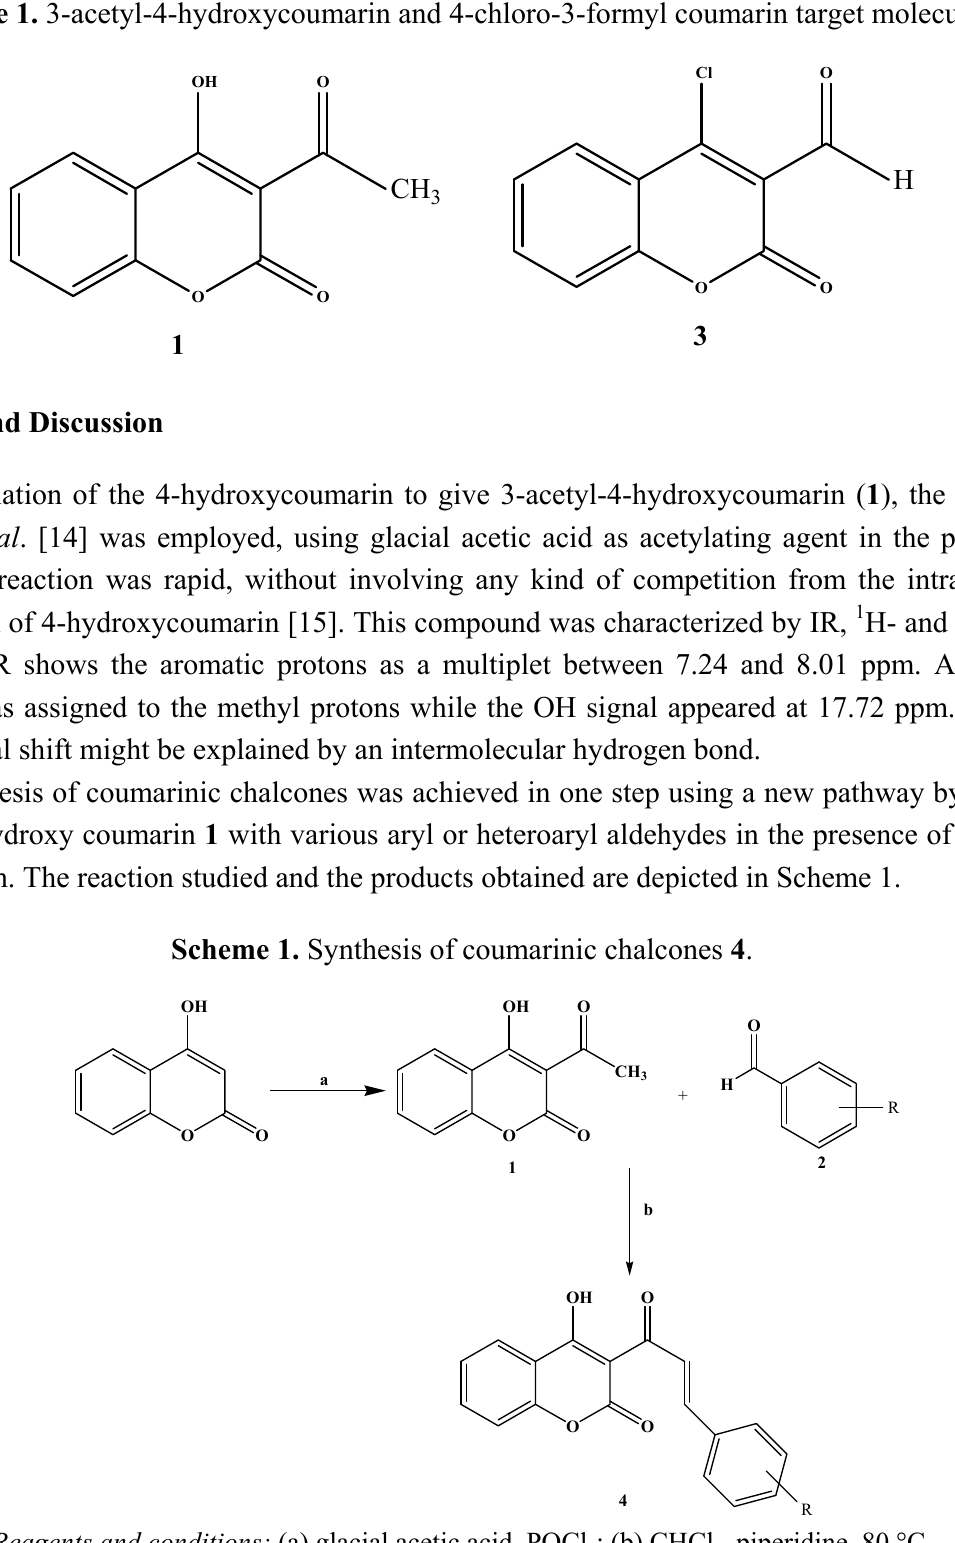
Figure 1. 3-acetyl-4-hydroxycoumarin and 4-chloro-3-formyl coumarin target